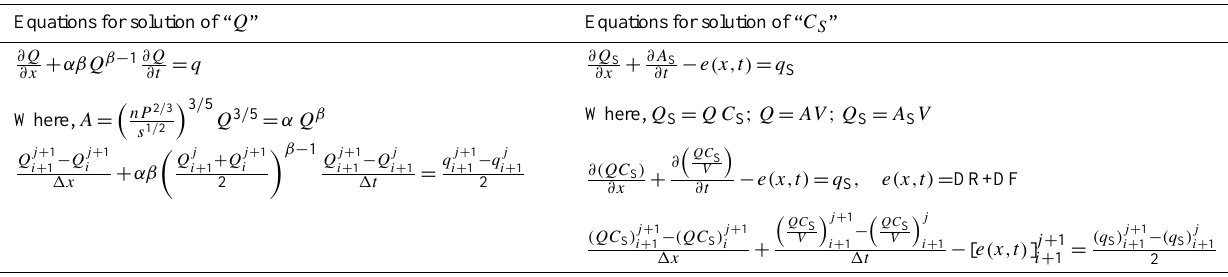
Table 2. Kinematic wave equations and finite difference interpretation. Equations for solution of “ Q ”